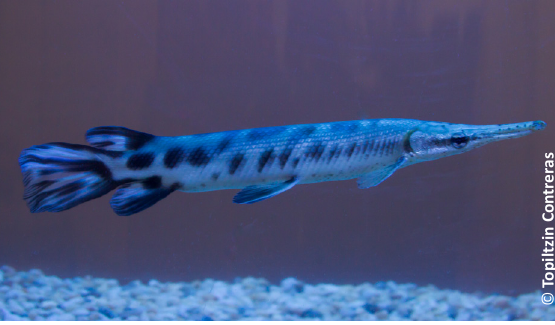
Image 7. Captive specimen of Spotted Gar Lepisoteus